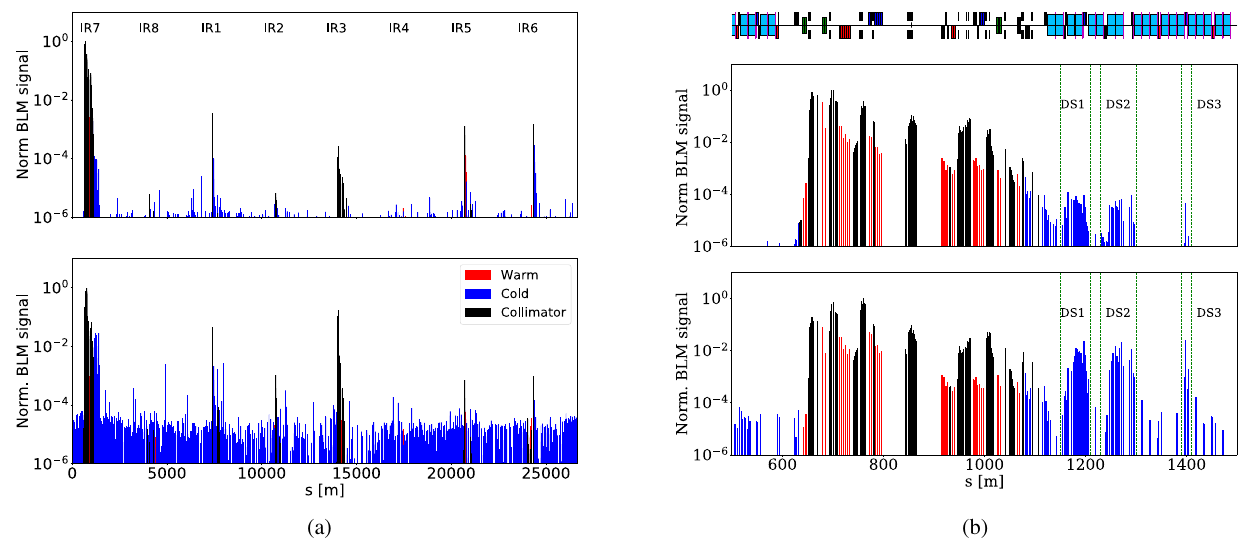
FIG. 3. Measured horizontal B1 full ring (a) and IR7 zoom (b) loss maps performed with colliding 6.5 TeV proton (top) and 6 . 37 Z TeV 208 Pb 82 þ ion (bottom) beams. In the IR7 zoom, the three clusters in the DS in which the highest cold loss spikes around the ring are observed, are indicated as DS1 ( s ¼ 1150 – 1210 m), DS2 ( s ¼ 1230 – 1300 m) and DS3 ( s ¼ 1390 – 1410 m). Note that the layout has been started in IR7 with the vertical TCP located at s ¼ 650 m. On the top of (b) the different layout elements are indicated: dipoles (light blue), focusing quadrupoles (blue), defocusing quadrupoles (red), sextupoles (green) and collimators